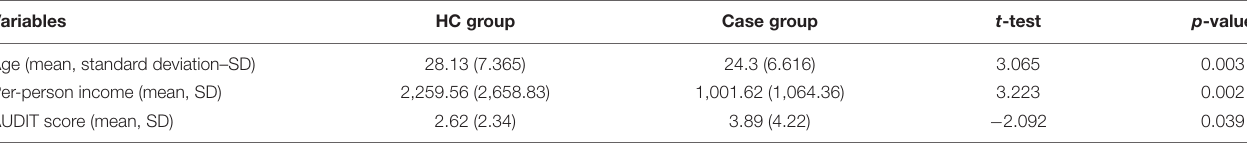
TABLE 1 | Descriptive participants’